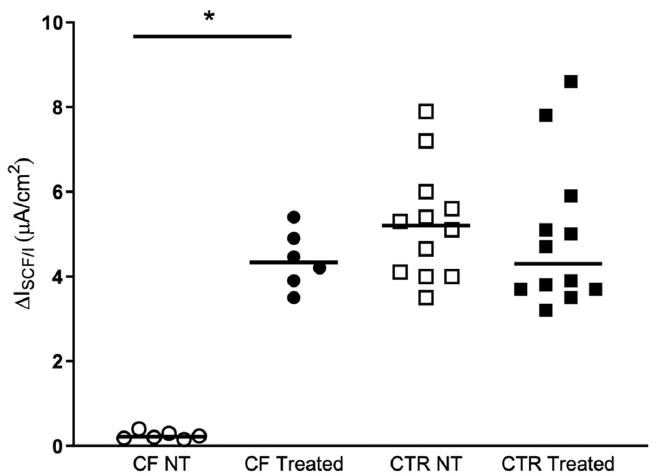
Figure 1. Short-circuit current (Isc) recording experiments on brushed nasal epithelial cells. Case 1 to 3 are short-circuit currents from CF patients with F508del/Unknown genotype treated with Kaftrio TM . Cells were treated with (green line) or without (dark red line) a combination of VX-445 (3 µ M), VX-661 (3 µ M) and VX-770 (100 nM) for 24 h. The black arrows indicate: A = addition of Amiloride (100 µ M) for ENaC channel activity inhibition, F = addition of Forskolin (10 µ M), IBMX (3-Isobutyl-1-methylxanthine) (100 µ M) for activation of the transepithelial cAMP-dependent current (including CFTR channel activity) and I = addition of Inh-172 (5 µ M) for CFTR specific inhibition. All chemicals were added to the apical/mucosal side of cells.